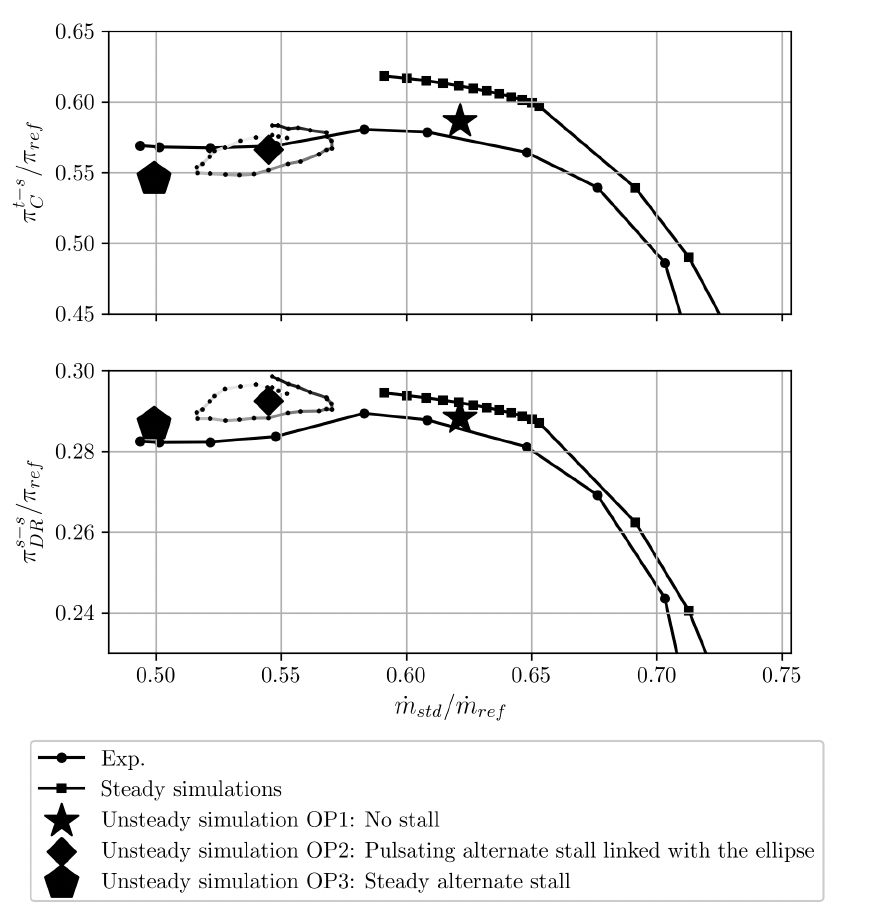
Figure 9. Performance comparison between experimental and numerical data: total-to-static pressure ratio of the compressor stage ( top ) and static-to-static pressure ratio of the radial diffuser ( bottom